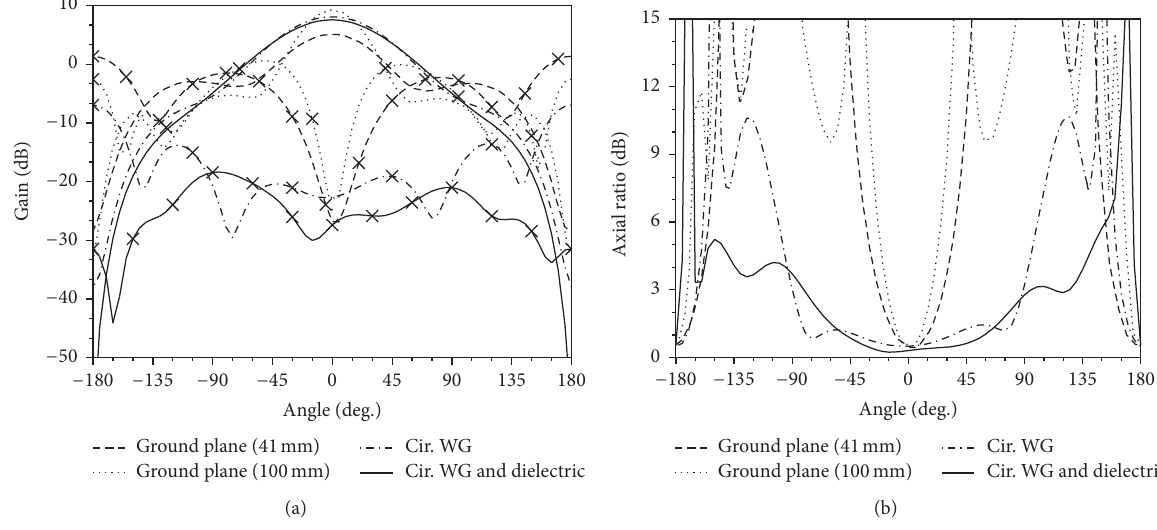
Figure 4: (a) Gain and (b) axial ratio patterns of the crossed dipoles of various configurations on zx